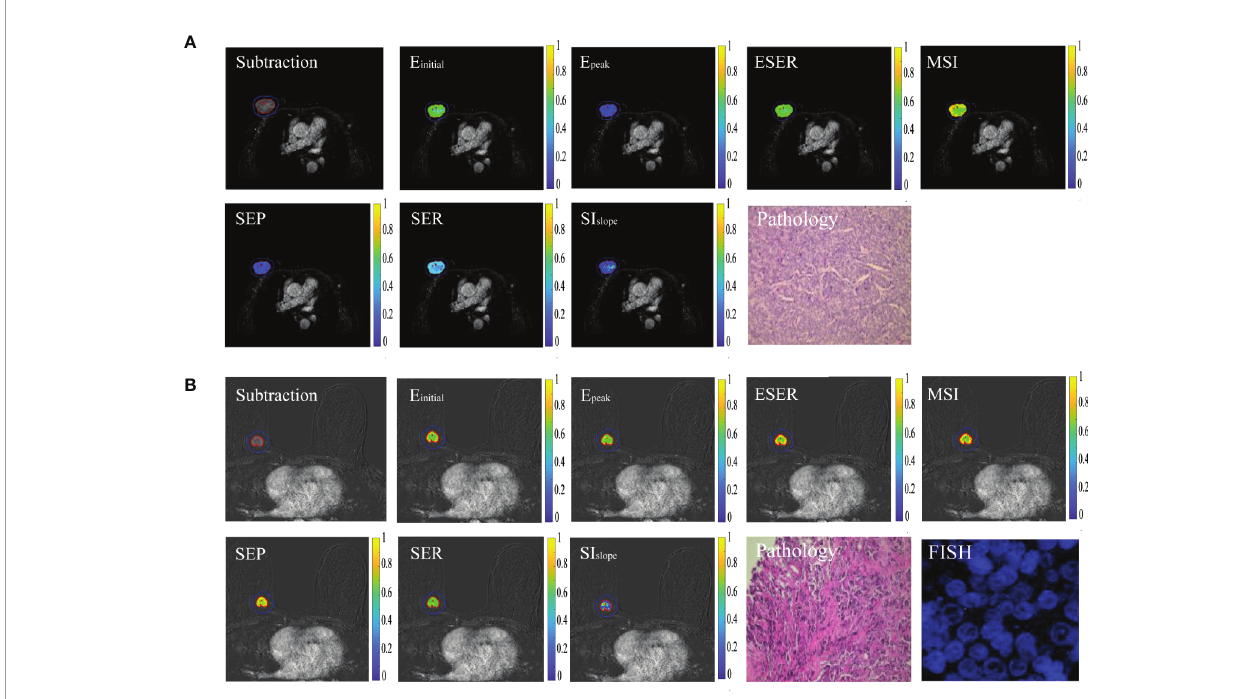
FIGURE 2 | Typical cases of HER2 positivity and negativity. (A) Sample images of HER2 positivity, including lesion segmentation, seven semiquantitative DCE maps, and corresponding pathological results. (B) Sample images of HER2